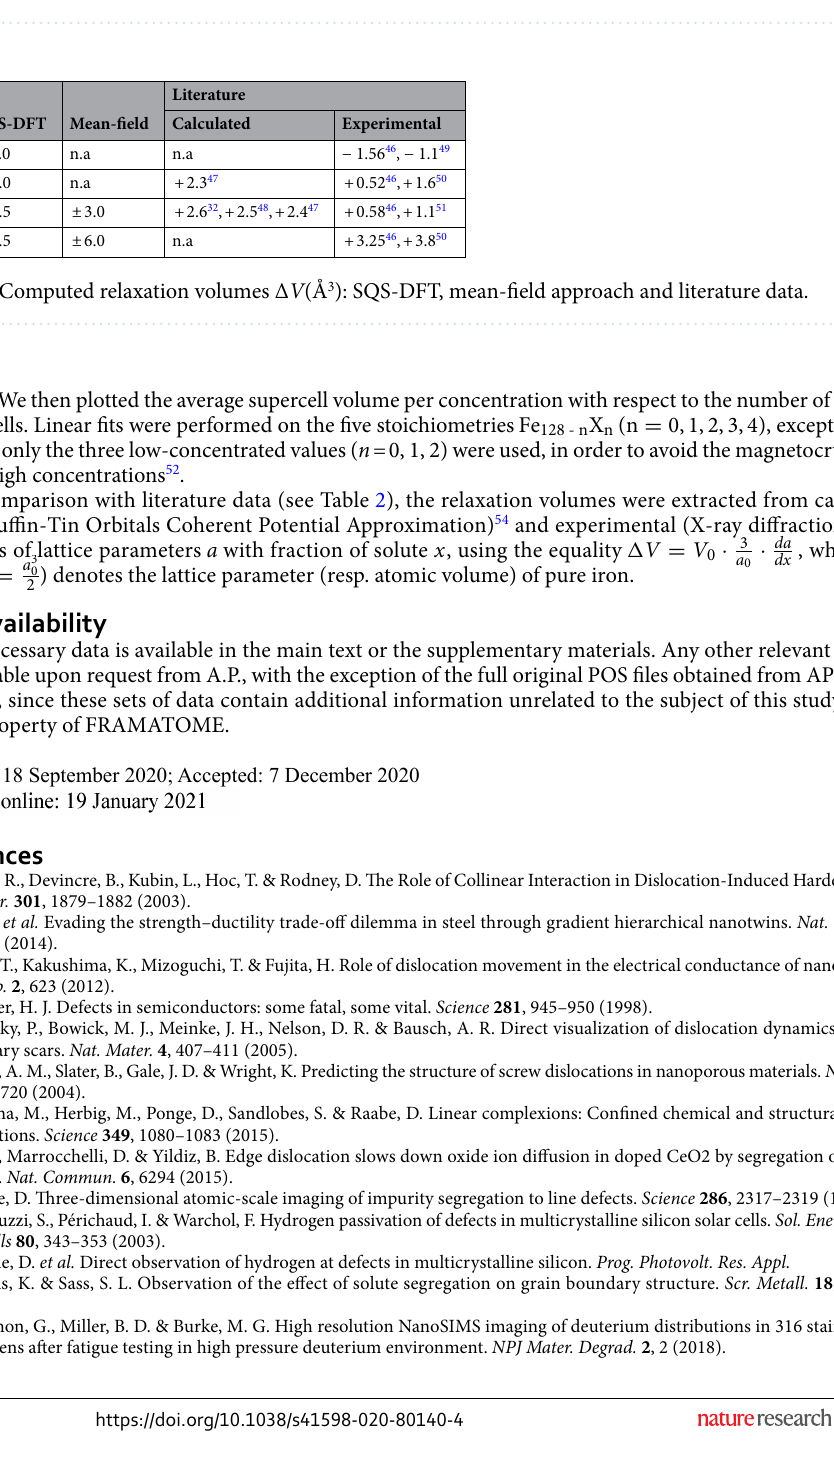
Table 1. Dislocation excess number ( Ŵ exp ) of different solute elements present in the low-carbon- concentration bcc-Fe sample (i.e. C, Mn, Mo, Ni, P, Cr, and Si) and their total excess number ( Ŵ T exp ) measured in different 1D edge-dislocation arrays exhibiting different inter-dislocation distance d . C is the only interstitial specie, all the other elements are substitutional in the Fe bcc lattice.